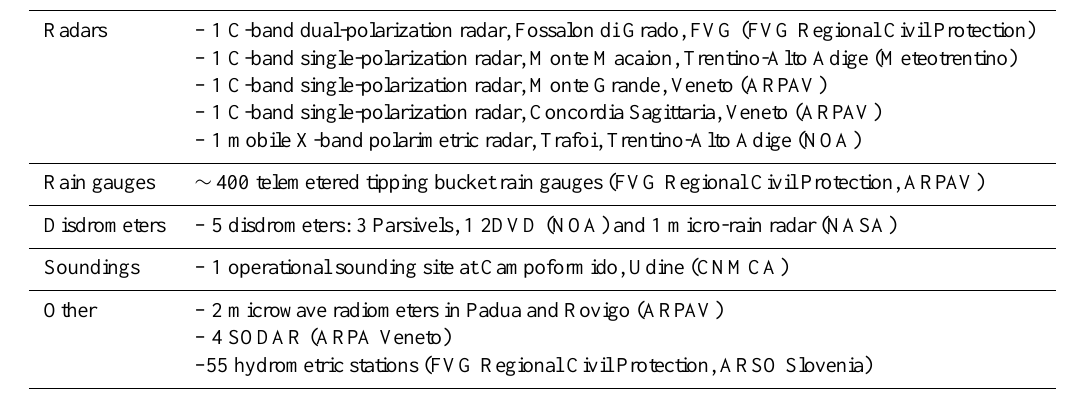
Table 3. Instrumentation deployed over the NEI area during SOP1 (in parentheses the responsible institutions). FVG stands for Friuli Venezia